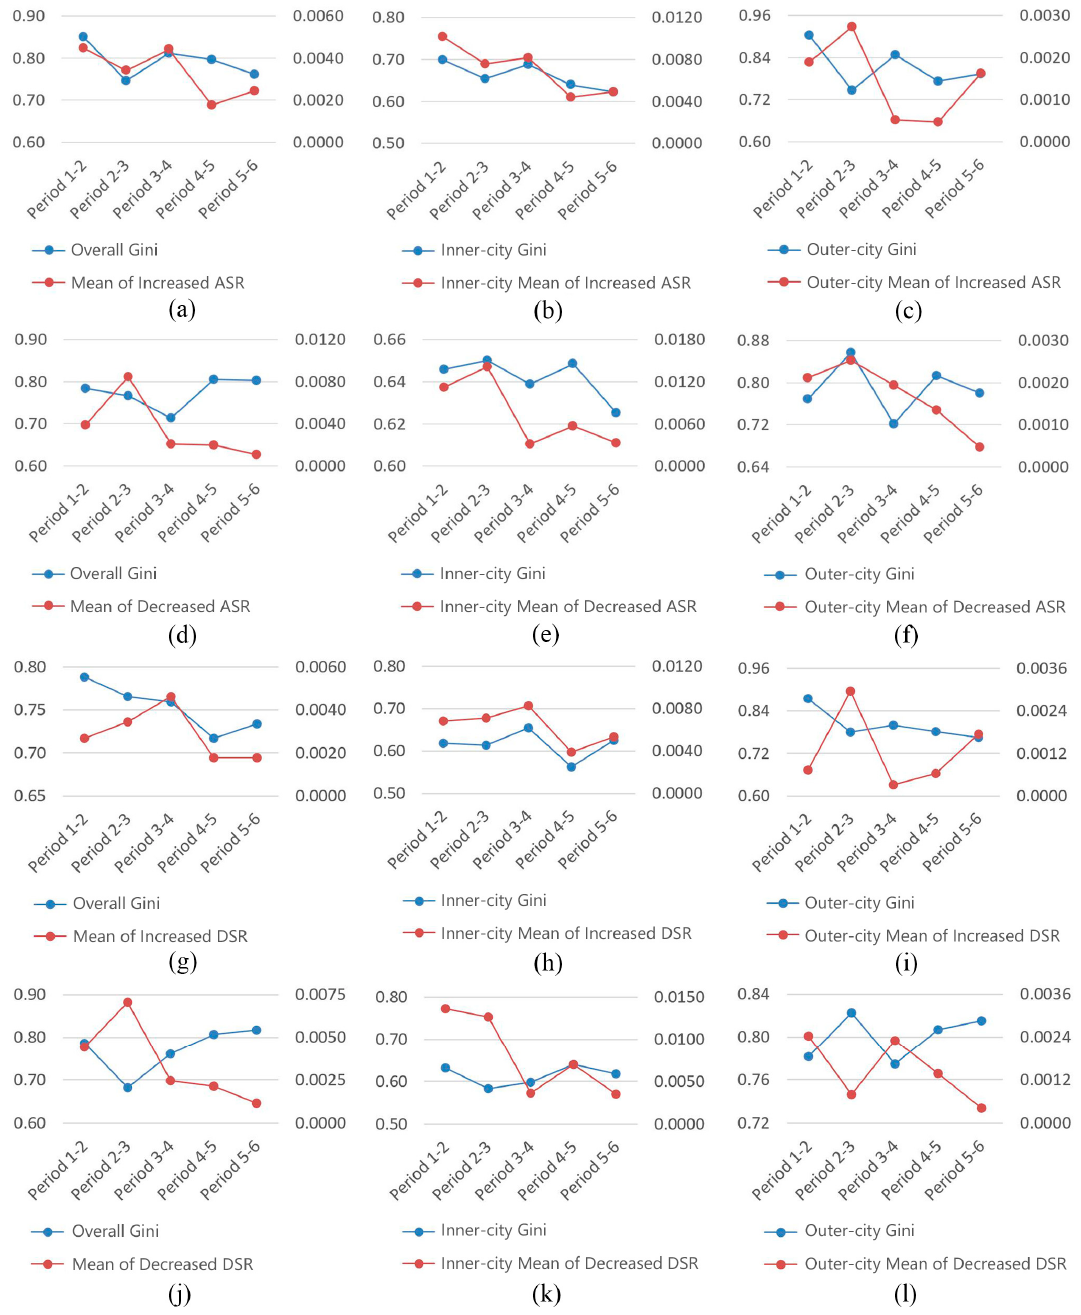
Figure 5. The changes of the Gini coefficient and the changes of the mean of the service rate change on weekdays between each pair of neighboring periods. Specifically, they are the overall changes of the Gini coefficient and the mean of increased ASR ( a ), the changes of the inner-city Gini coefficient and the inner-city mean of increased ASR ( b ), the changes of the outer-city Gini coefficient and the outer-city mean of increased ASR ( c ), the overall changes of the Gini coefficient and the mean of decreased ASR ( d ), the changes of the inner-city Gini coefficient and the inner-city mean of decreased ASR ( e ), the changes of the outer-city Gini coefficient and the outer-city mean of decreased ASR ( f ), the overall changes of the Gini coefficient and the mean of increased DSR ( g ), the changes of the inner-city Gini coefficient and the inner-city mean of increased DSR ( h ), the changes of the outer-city Gini coefficient and the outer-city mean of increased DSR ( i ), the overall changes of the Gini coefficient and the mean of decreased DSR ( j ), the changes of the inner-city Gini coefficient and the inner-city mean of decreased DSR ( k ), and the changes of the outer-city Gini coefficient and the outer-city mean of decreased DSR ( l ).